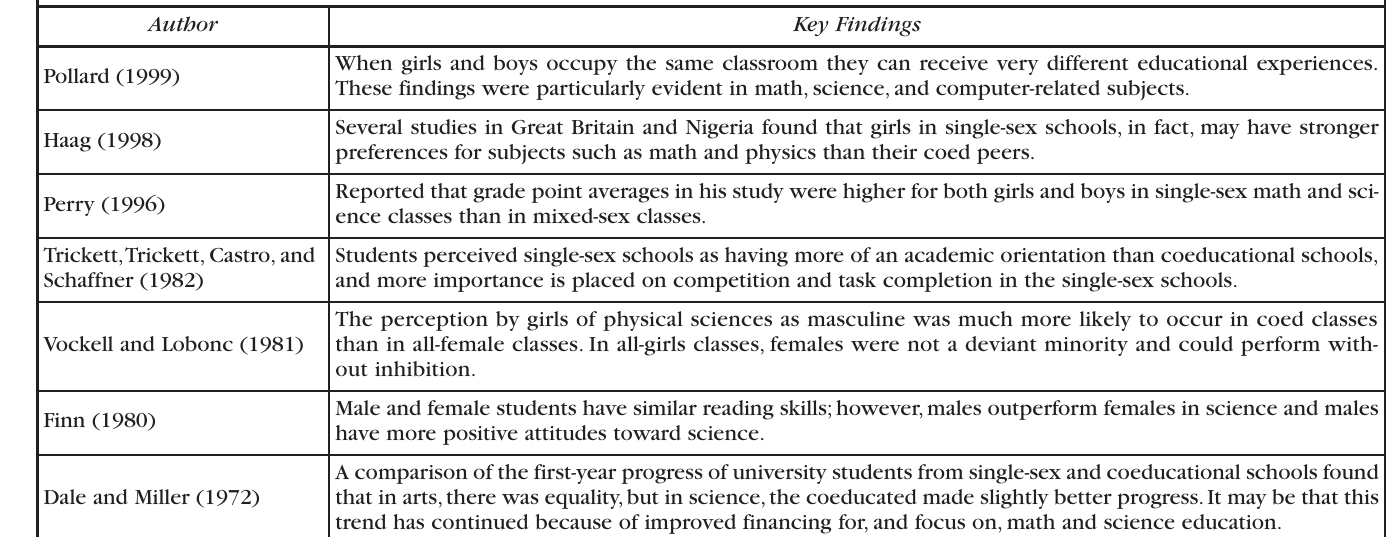
Table 1. Math or Science Differences Found in Single-Sex Education